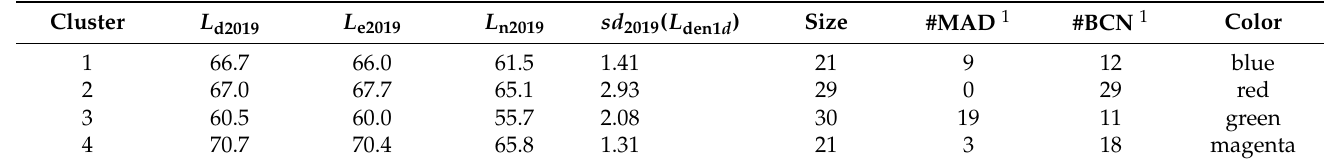
Figure 4. Nodes distribution within clusters by distance for k = 4 Hierarchical Agglomeration clustering. abbreviations: MAD X Madrid Stations, BCN X Barcelona Stations. Clusters groups are colored as presented in Table 7. Table 7. Size and centroid of clusters using data collected during 2019 for k = 4 Hierarchical Agglomeration